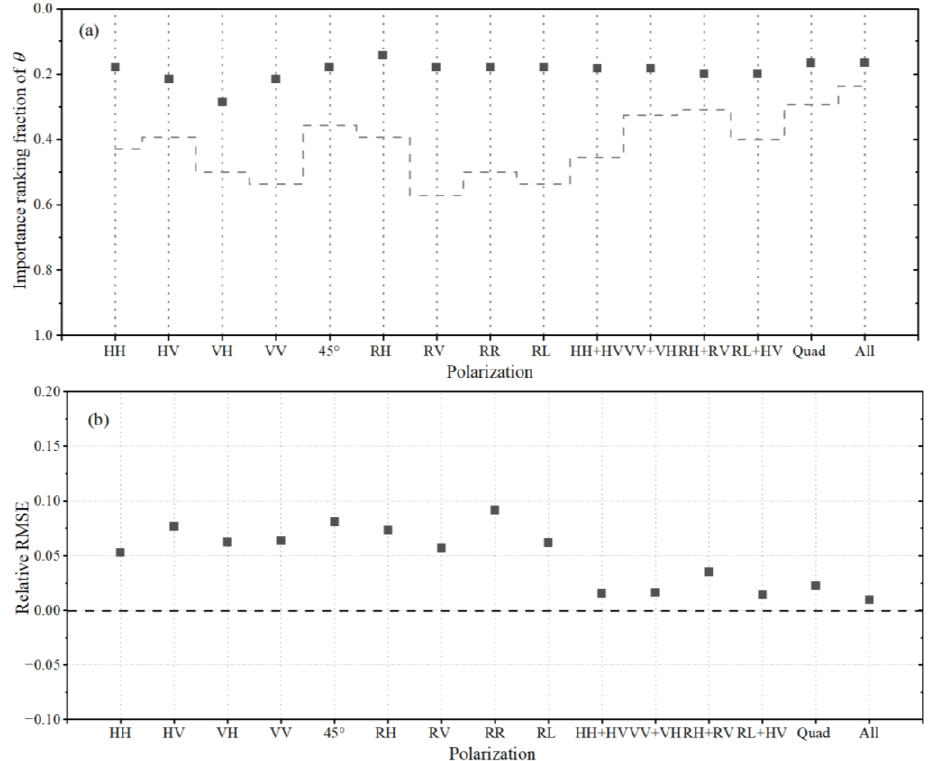
Figure 31. The importance of θ to SWH retrieval from different polarization models. ( a ) The impor- tance ranking of θ provided by XGBoost models, normalized to the range of 0–1. ( b ) The effect of removing θ on the SWH estimation from different polarized